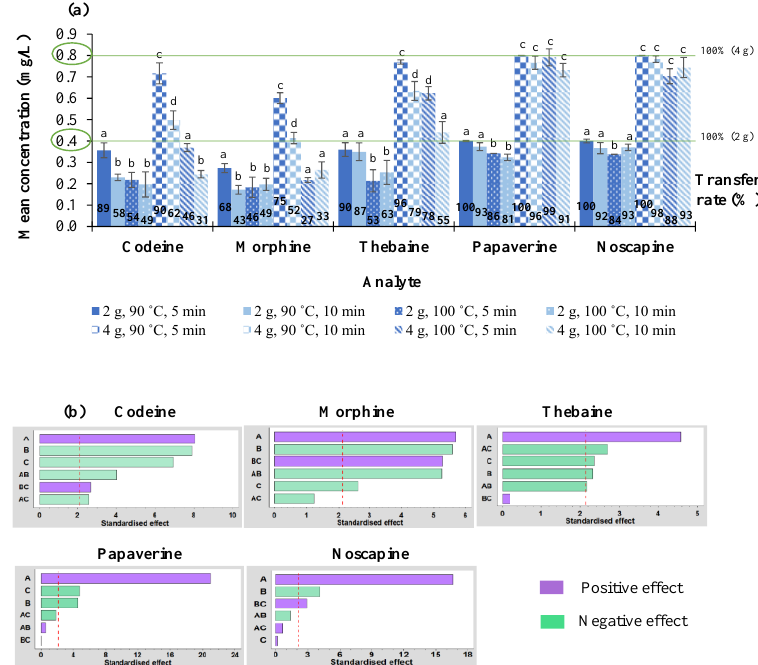
Figure 5. Mean concentrations ( n = 3) obtained in each transfer study with their transfer rates (%). The same letters mean that there were no statistically significant differences; different letters mean that there were such differences ( p ≤ 0.05) ( a ). Pareto Chart of the standardized effect of each of the responses (concentration of each analyte), showing the three factors: (A) poppy seed amount (g), (B) infusion time (min) and (C) temperature (°C) ( b ).